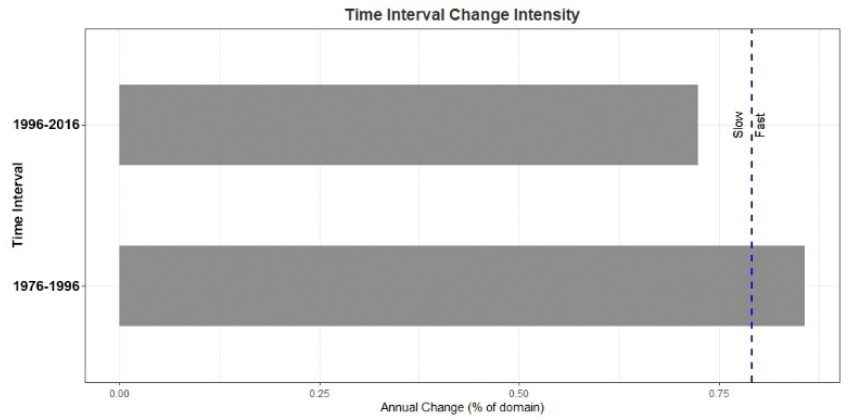
Figure 9. Time interval change intensity (annual change %).